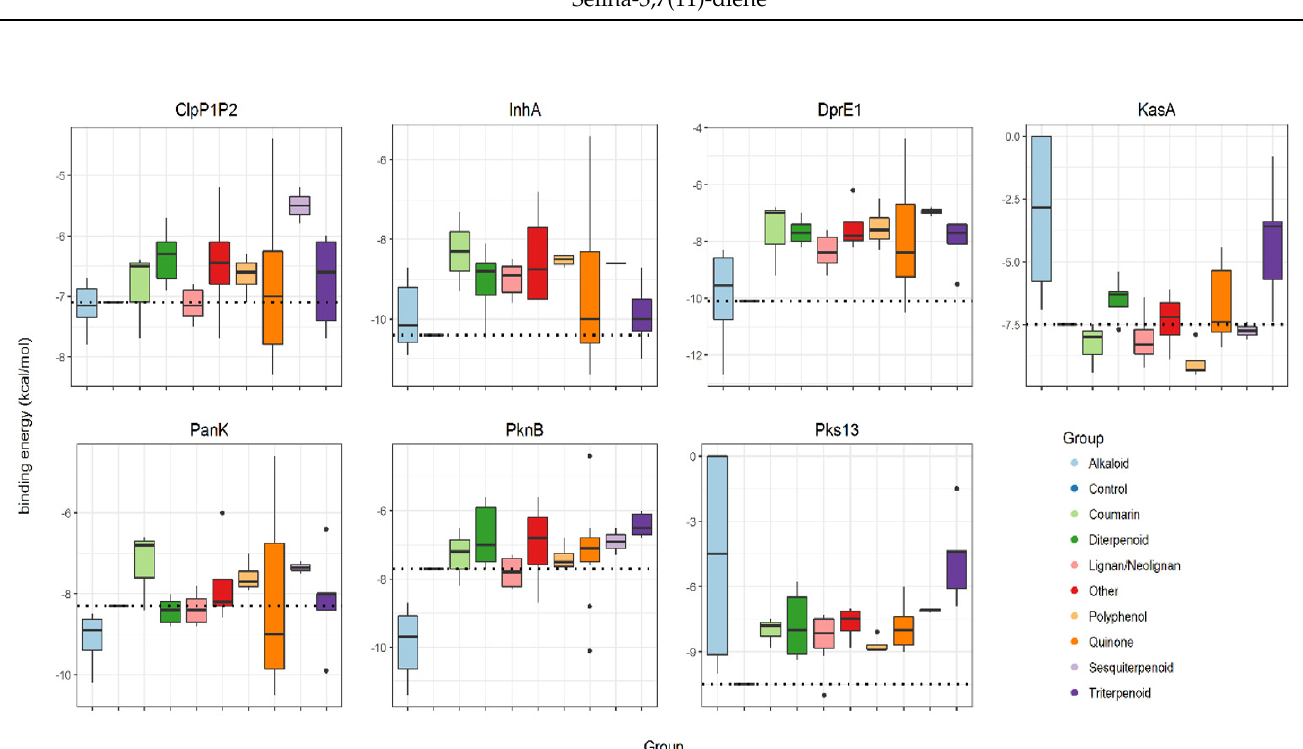
Figure 1. Binding energies (kcal·mol − 1 ) of groups of selected natural products (alkaloids, coumarins, diterpenoids, lignans/neolignans, polyphenols, quinones, sesquiterpenoids, triterpenoids and others) and controls (represented with dashed lines) against mycobacterial targets ClpP1P2, InhA, DprE1, KasA, PanK, PknB and Pks13. Control inhibitors of each protein are, respectively, ZIL (N-[(benzyloxy)carbonyl]-L-isoleucyl-L-leucine), BTZ043 (bedaquiline), isoniazid, TLM (thiolactomycin), ZVT(2-chloro- N -[1-(5-{[2-(4-fluorophenoxy)ethyl]sulfanyl}-4-methyl-4 H -1,2,4-triazol-3-yl)ethyl]ben- zamide),MIX(1,4-dihydroxy-5,8-bis({2-[(2-hydroxyethyl)amino]ethyl}amino)-9,10-antracenedione)andI28(ethyl-5-hy- droxy-4-[(4-methylpiperidin-1-yl)methyl]-2-phenyl-1-benzofuran-3-carboxylate).